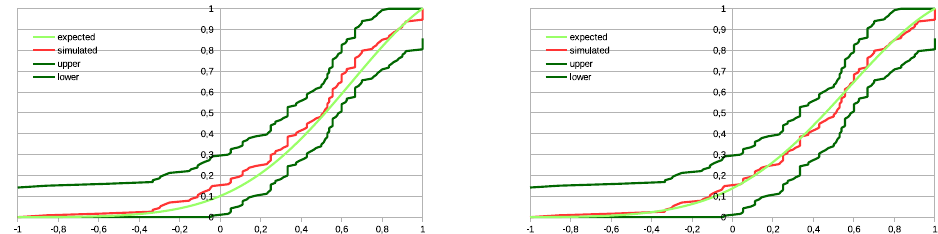
Figure 4. Simulated cumulative frequency distribution (red) for a run with κ = 0.5701 and δ = 0.9718 and one school year—1967/68—and its 80 per cent conficence band (dark green) and the expected cumulative frequency distributions (light green) for the resulting κ ∗ = 1.1402 and δ ∗ = 0.4017 (left) and with κ ∗ = 1.1 and δ ∗ = 1.3 corresponding to κ = 0.55 and δ = 0.75